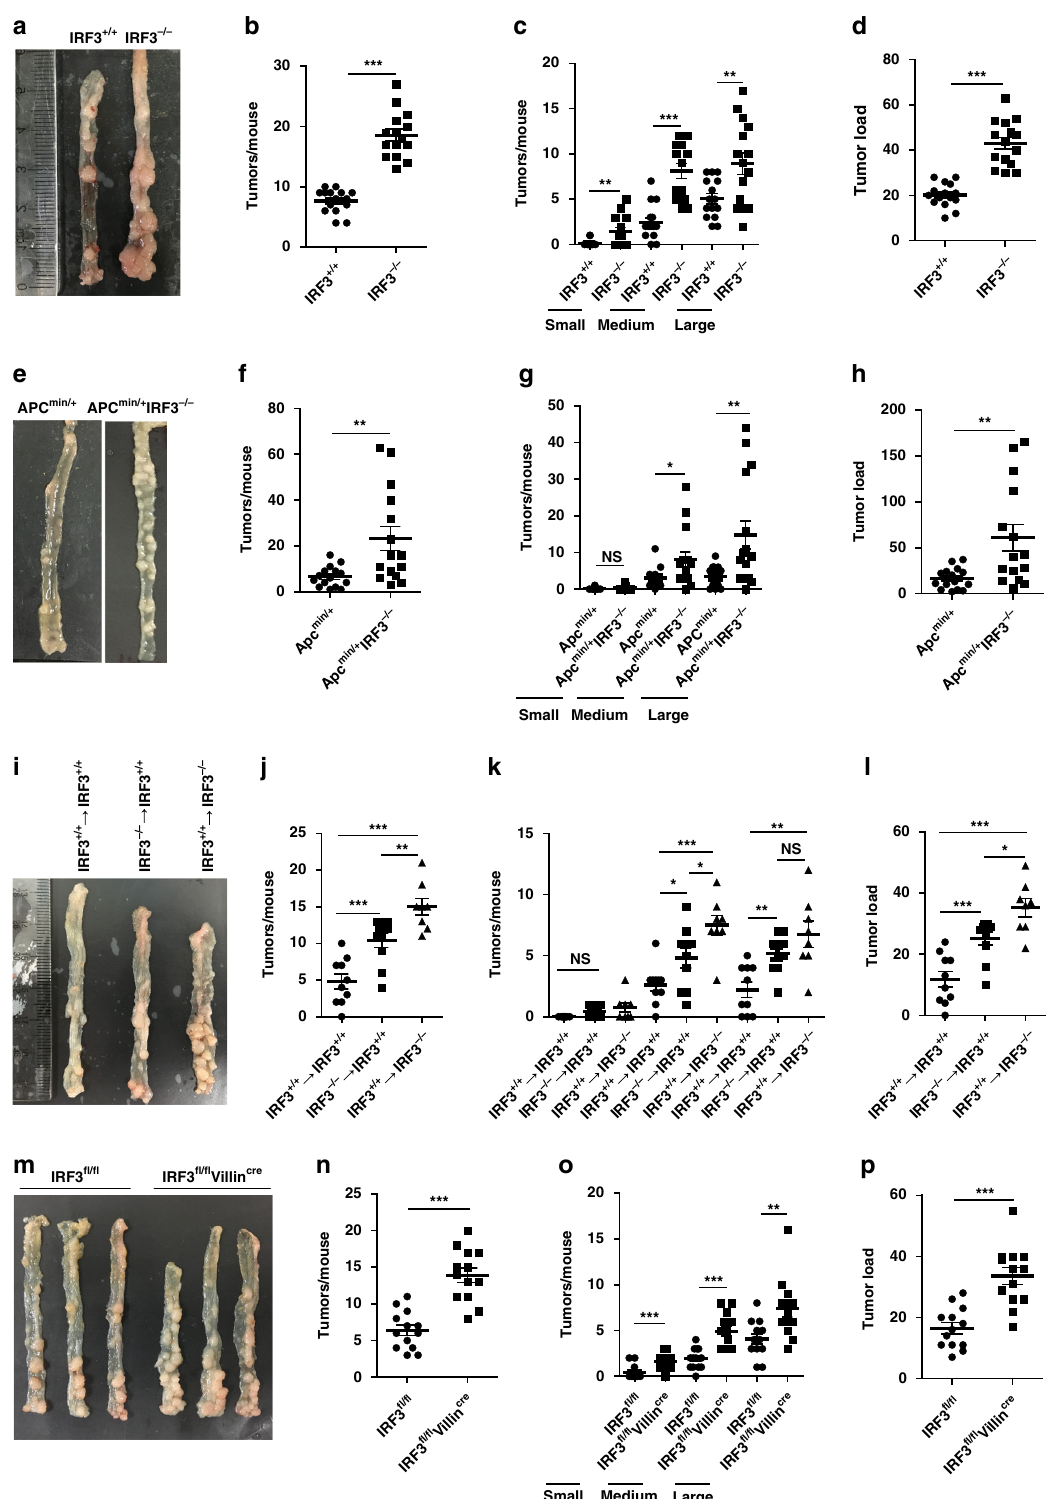
Fig. 1 IRF3 in intestinal epithelium protects against colonic tumorigenesis. a Representative images of colon tumors from IRF3 + / + and IRF3 − / − mice on day 90 after AOM/DSS model. b – d Colon tumor counts, size, and tumor load from IRF3 + / + and IRF3 − / − mice ( n = 15 mice/group) after AOM/DSS model (day 90). e Representative images of the small intestine and tumors in Apc min/ + and Apc min/ + IRF3 − / − mice. f – h Intestinal tumors counts, size, and tumor load from Apc min/ + and Apc min/ + IRF3 − / − mice ( n = 15 mice/group). i – l Three groups of mice were generated by bone marrow transplantation: IRF3 + / + → IRF3 + / + , n = 10; IRF3 − / − → IRF3 + / + , n = 10; IRF3 + / + → IRF3 − / − , n = 8; the numbers and size of tumors in the colon were quanti fi ed after AOM/DSS model (day 90). m – p Colon tumor counts, size, and tumor load from IRF3 fl / fl and IRF3 fl / fl Villin cre mice ( n = 13 mice/group) representative images of colons at left ( m ) after AOM/DSS model (day 90). Each symbol represents one mouse ( b – d , f – h , j – l , n – p ). * P <0.05; ** P <0.01; *** P <0.001; NS not statistically signi fi cant by two-tailed t test ( b – d , f – h , j – l , n – p ). Data are from two independent experiments ( a – p ) and are presented as mean±s.e.m. in b – d , f – h , j – l , n – p . See also Supplementary Fig.